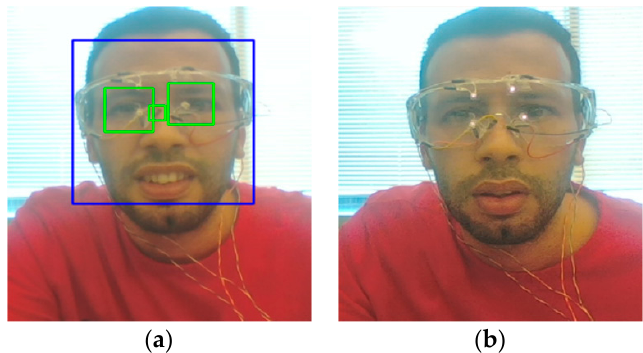
Figure 9. FacePET wearable experiment with IR LEDs. ( a ) With goggles off; ( b ) With goggles on. Note that the squares in the left figure and the IR LEDs on the right figure are turned on (LEDS seen as bright white lights between the eyes and around the nasal bone). In the left figure the green and blue squares indicate that a face was detected. In the right figure, the absence of squares indicates that no face was detected.